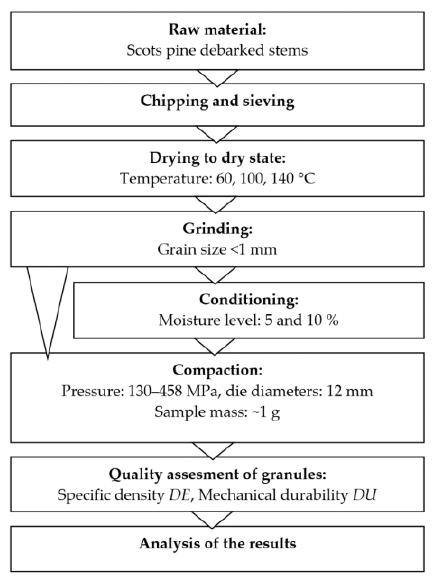
Figure 2. Flowchart of the procedure used for the investigations in this work.